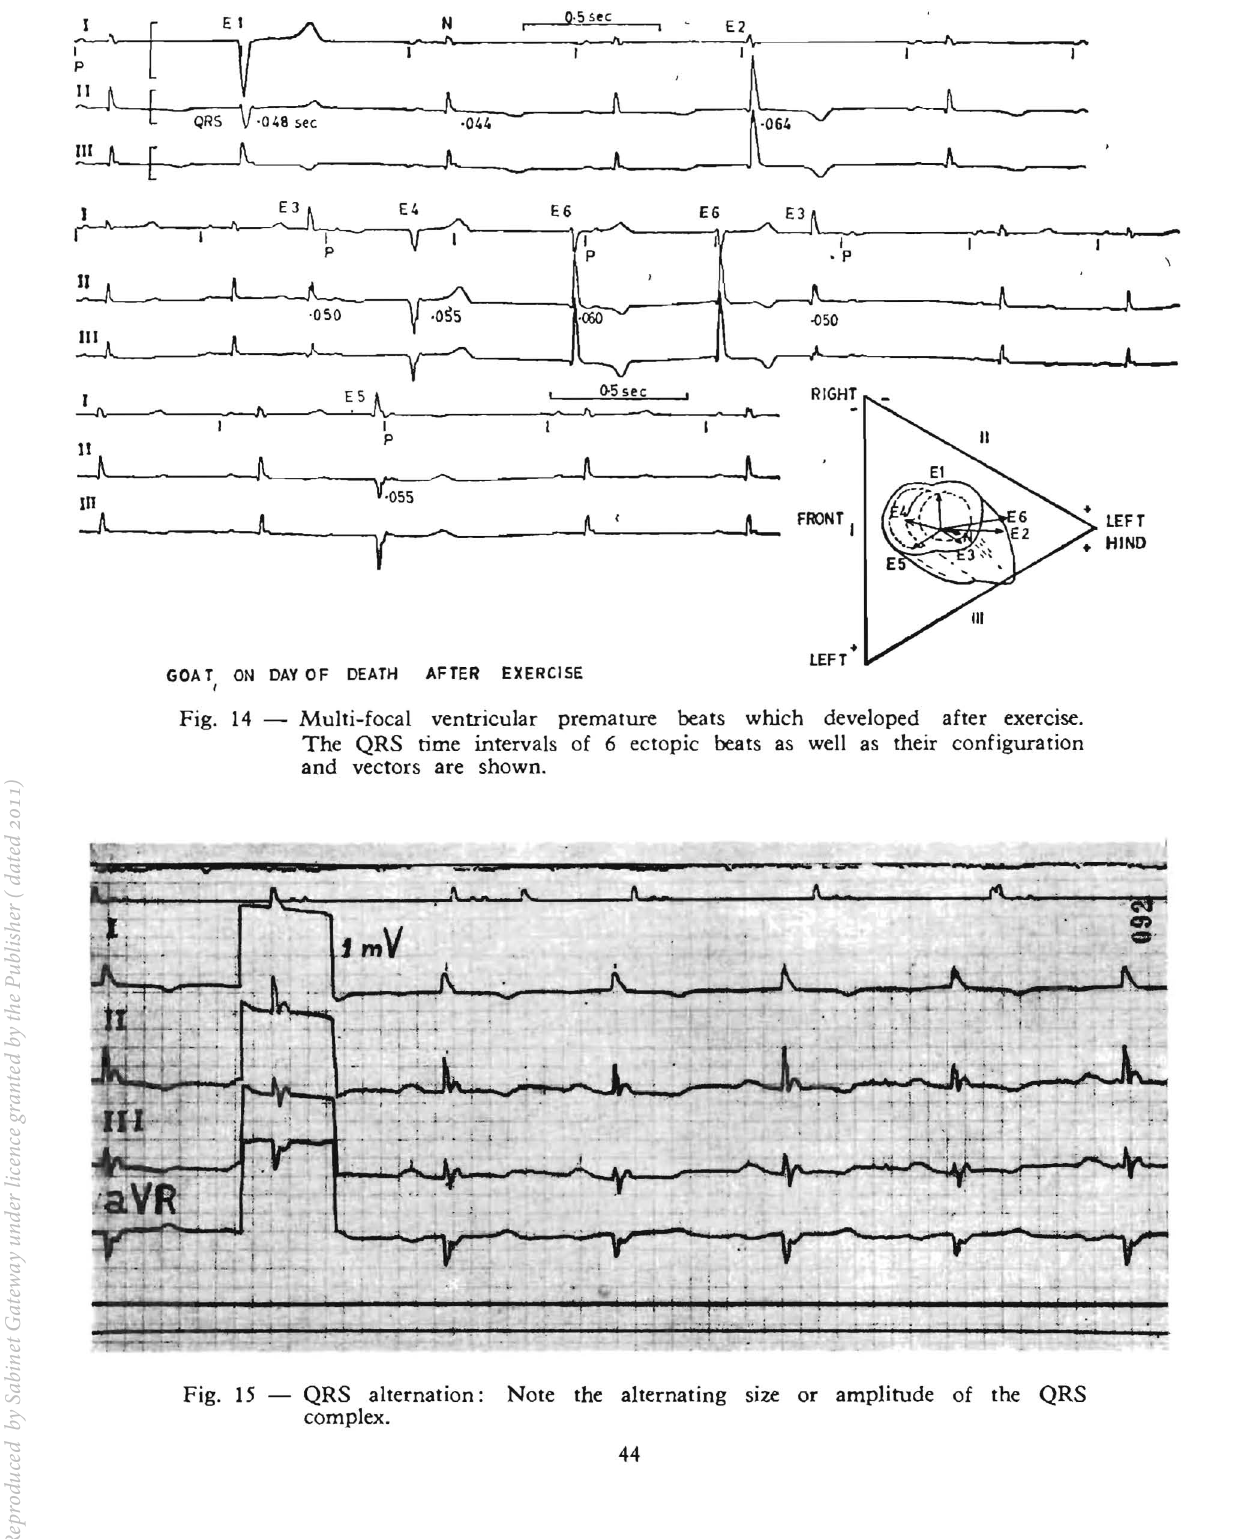
Fig. 15 - QRS alternation: Note the alternating size or amplitude of the QRS complex.